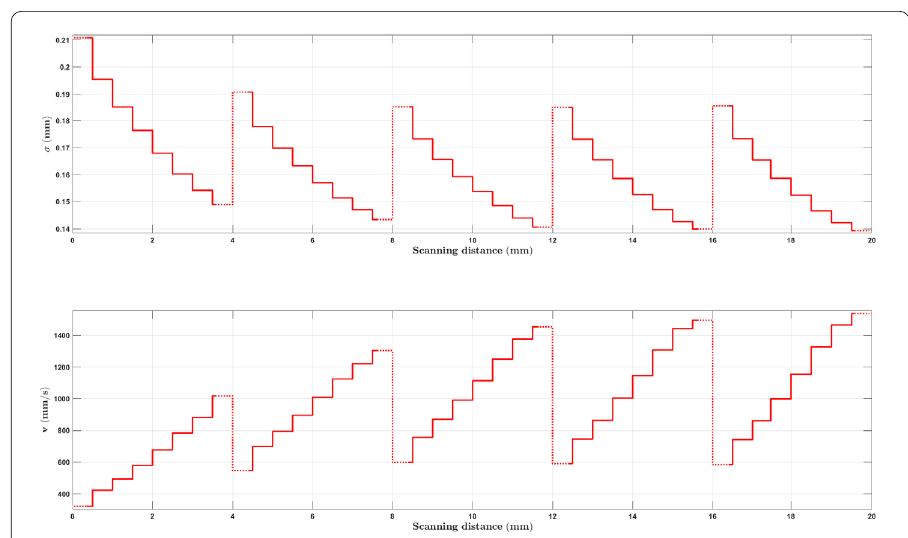
Figure 11 Optimal beam parameters in the second example, as obtained by the first greedy algorithm. The dotted parts indicate the places where the weight α is 0 (the start and end of the hatch lines). The parameter values start to stabilize somewhat by the fifth line. This motivates us to copy the parameter values for the fifth line to the remaining lines 6-19 that were omitted in the